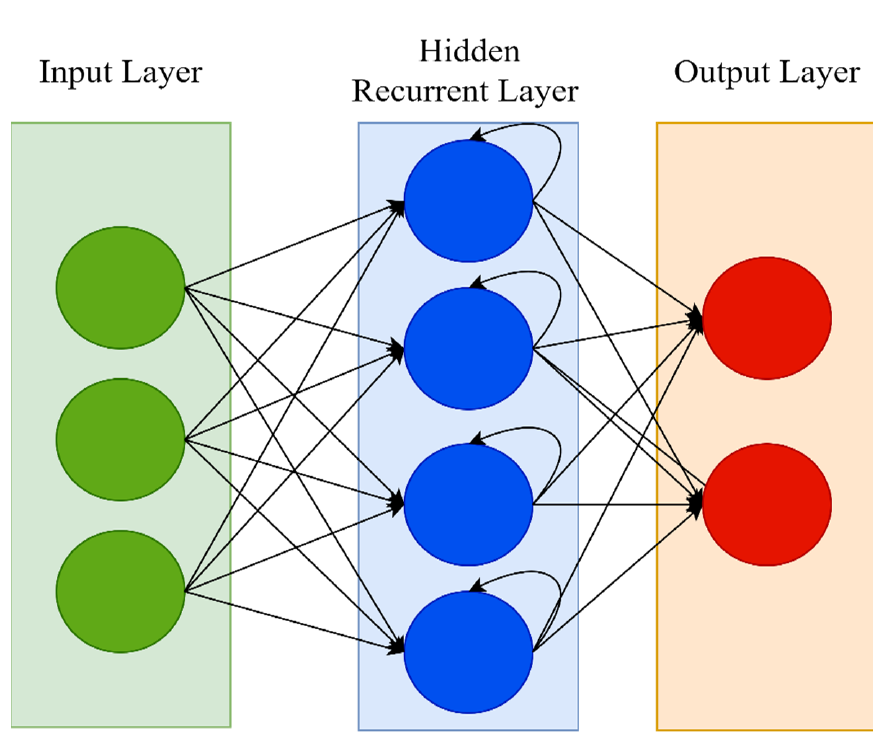
Figure 3. RNN architecture.